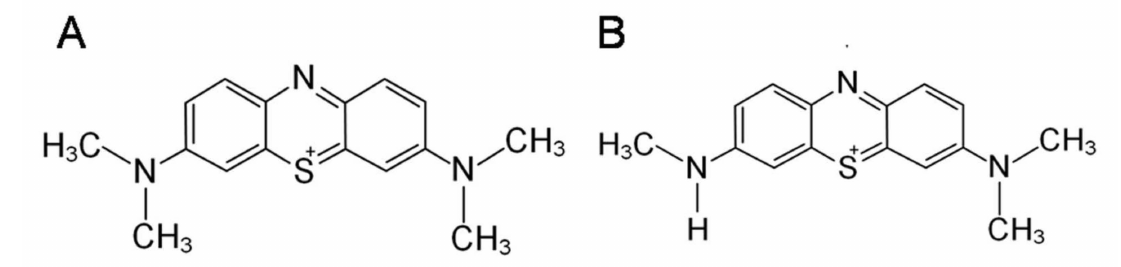
Figure 1. Chemical formulas of neuroprotective compounds: ( A ) methylene blue, ( B ) Azur